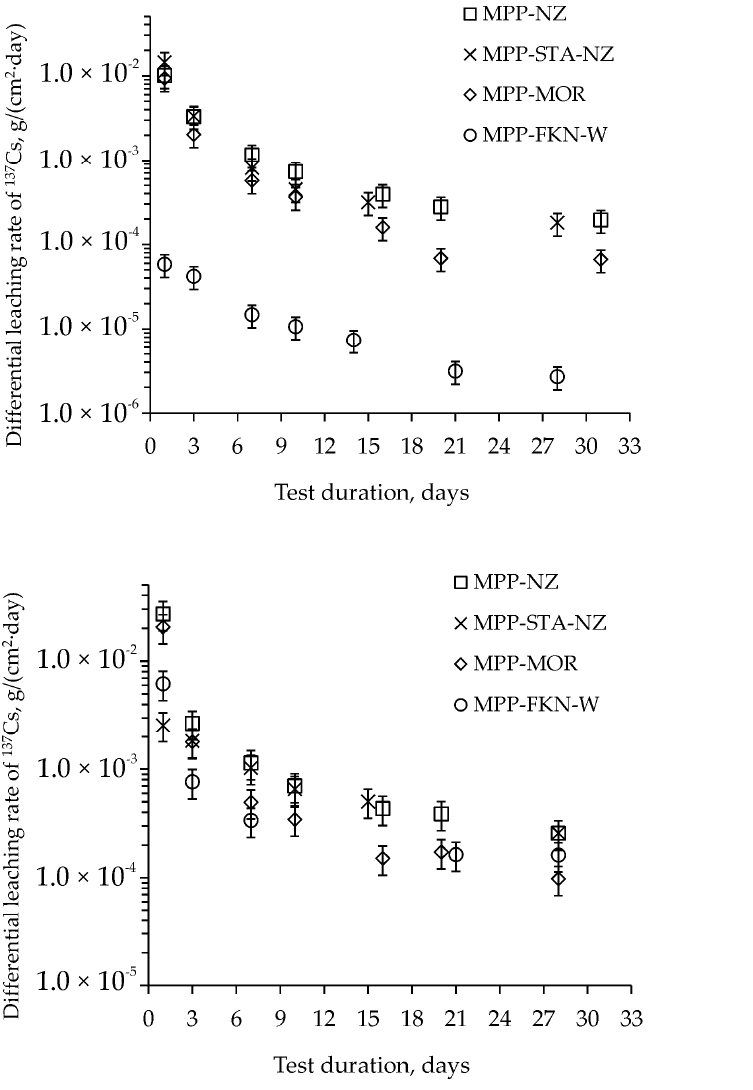
Figure 6. Kinetic curves of the 137 Cs leaching rate from the compounds after heat treatment at 180 ( a ) and 450 °C ( b ).